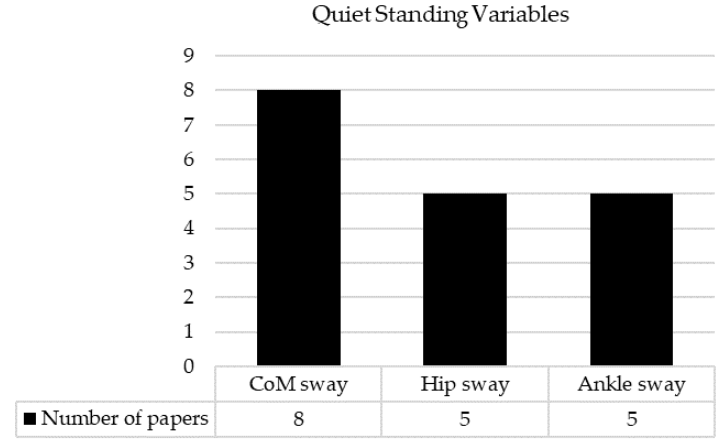
Figure 5. The number of papers for each quiet standing variable.